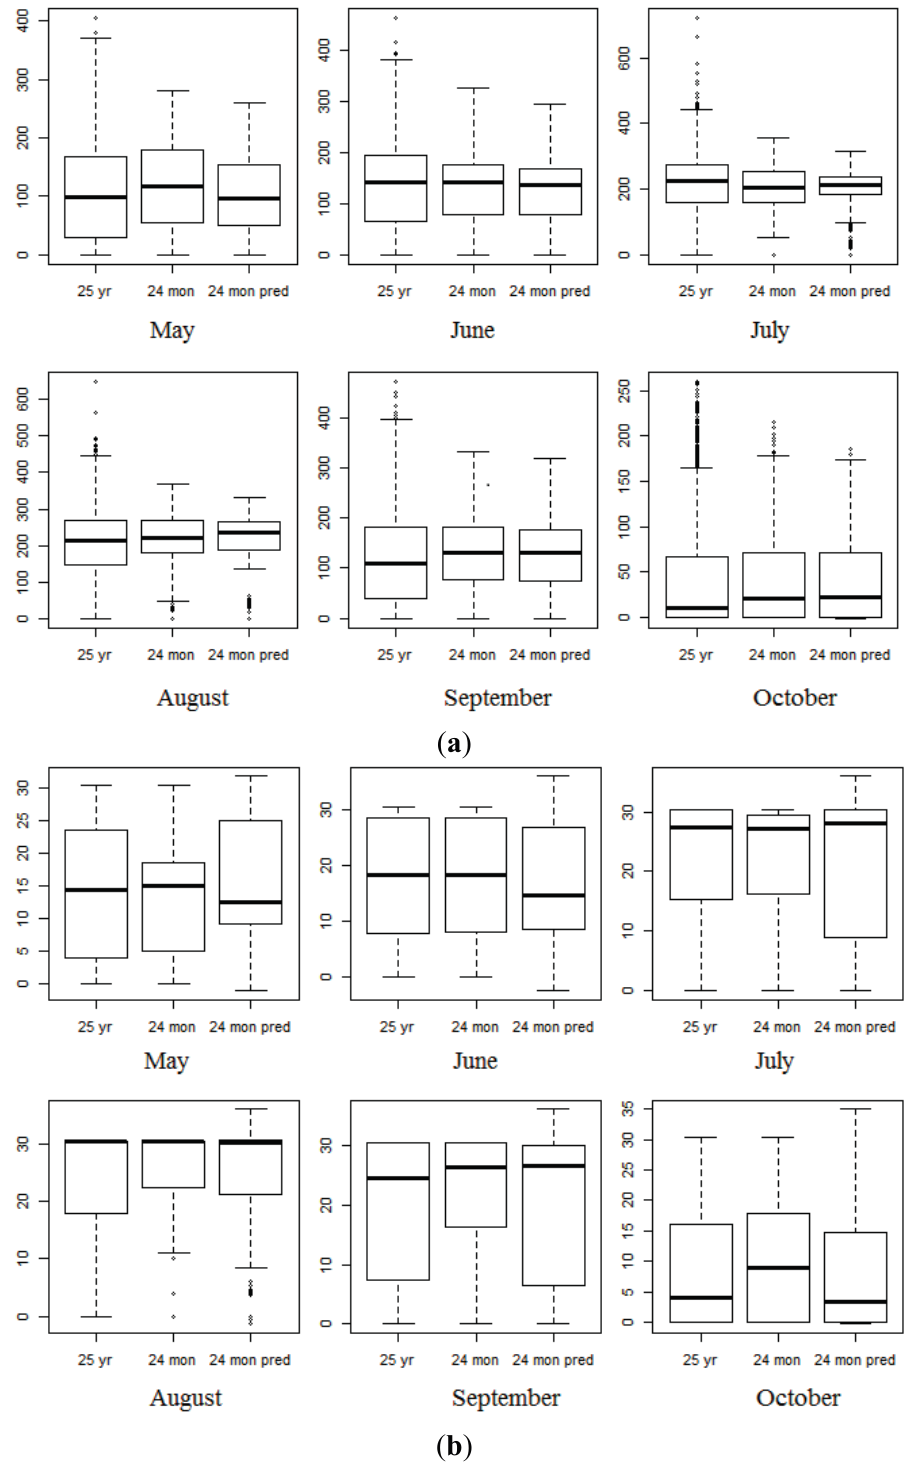
Figure 4. Monthly means and variabilities throughout the study area of the 25 years (1980–2004), 2005 and 2006 NCEP-CRU data and 2005–2006 model predictions of ( a ) monthly rainfall in mm and ( b ) the frequency of the number of rain days in a month (in days) from May–October. The first box (25 yr) shows the 25-year data used in making the 24 months prediction into the future, “24 mon” is the 24 months reference data and “24 mon pred” is the prediction. The values are inclusive of all grids for the months